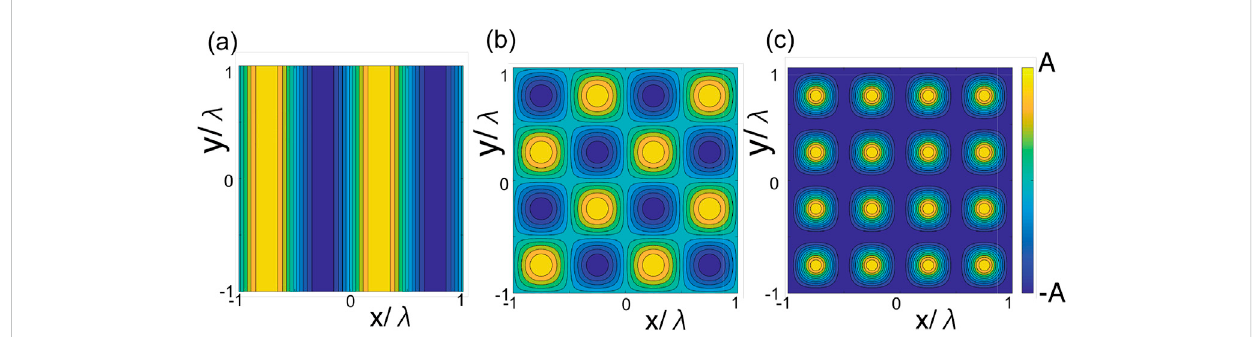
FIGURE 2 Illustrationsofthesurfacetopography functions h ( x , y )considered inthisstudy. (A) Singly periodic sinusoidal wavetopography, (B) doubly – periodic sinusoidal wave, and (C) doubly – periodic peaks, respectively, associated with Eqs 4 – 6. The maximum and minimum heights, h ( x , y ), are + A and − A for all